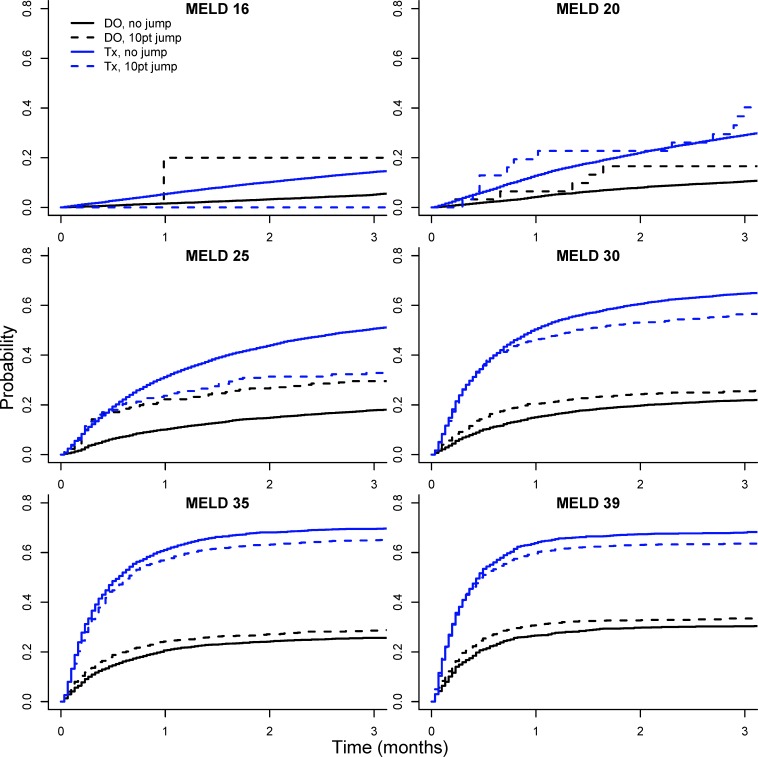
Cumulative incidence curves for waitlist dropout (DO) and transplantation (Tx).Cumulative incidence curves for waitlist dropout (black lines) and transplantation (blue lines) for patients with (dashed line) and without (solid line) a ΔMELD30 ≥ 10 jump at various MELD scores. Based on UNOS/OPTN data for registrants added to the liver transplant waitlist between 06/30/2003 and 6/30/2013.